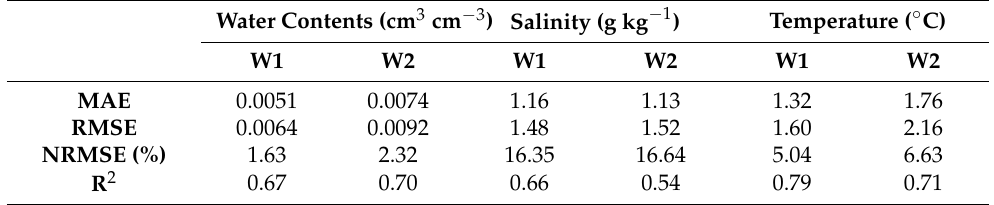
Table 3. Results of the statistical analysis between measured and simulated